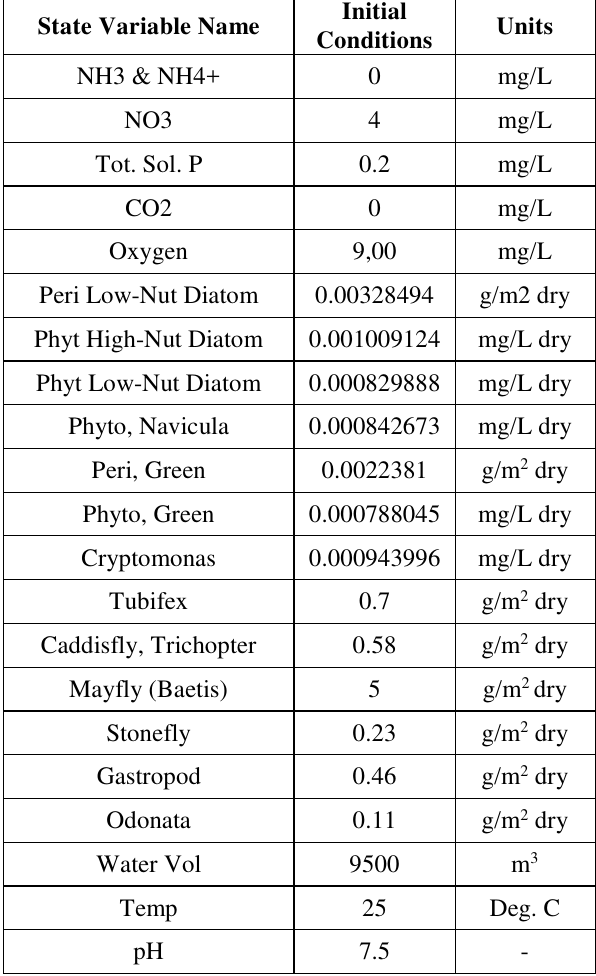
Table 2. Initial conditions for Cixerri